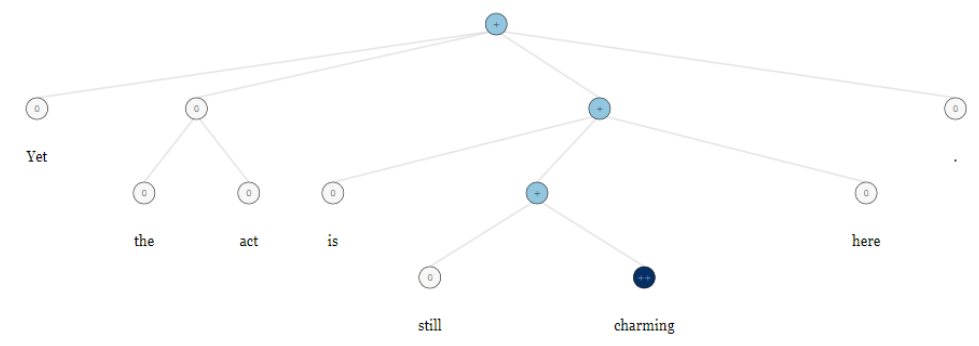
Figure 1. This is a figure. Schemes follow the same